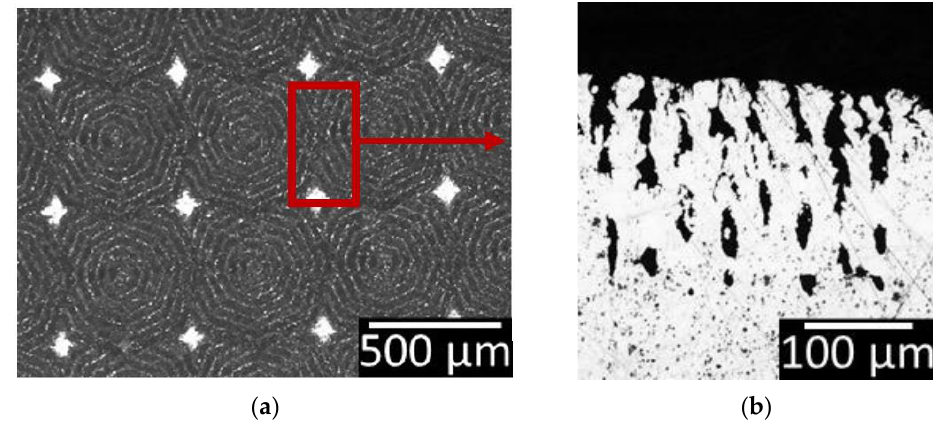
Figure 12. Observations of intersections top view ( a ); and cross-section of the selected area ( b ).